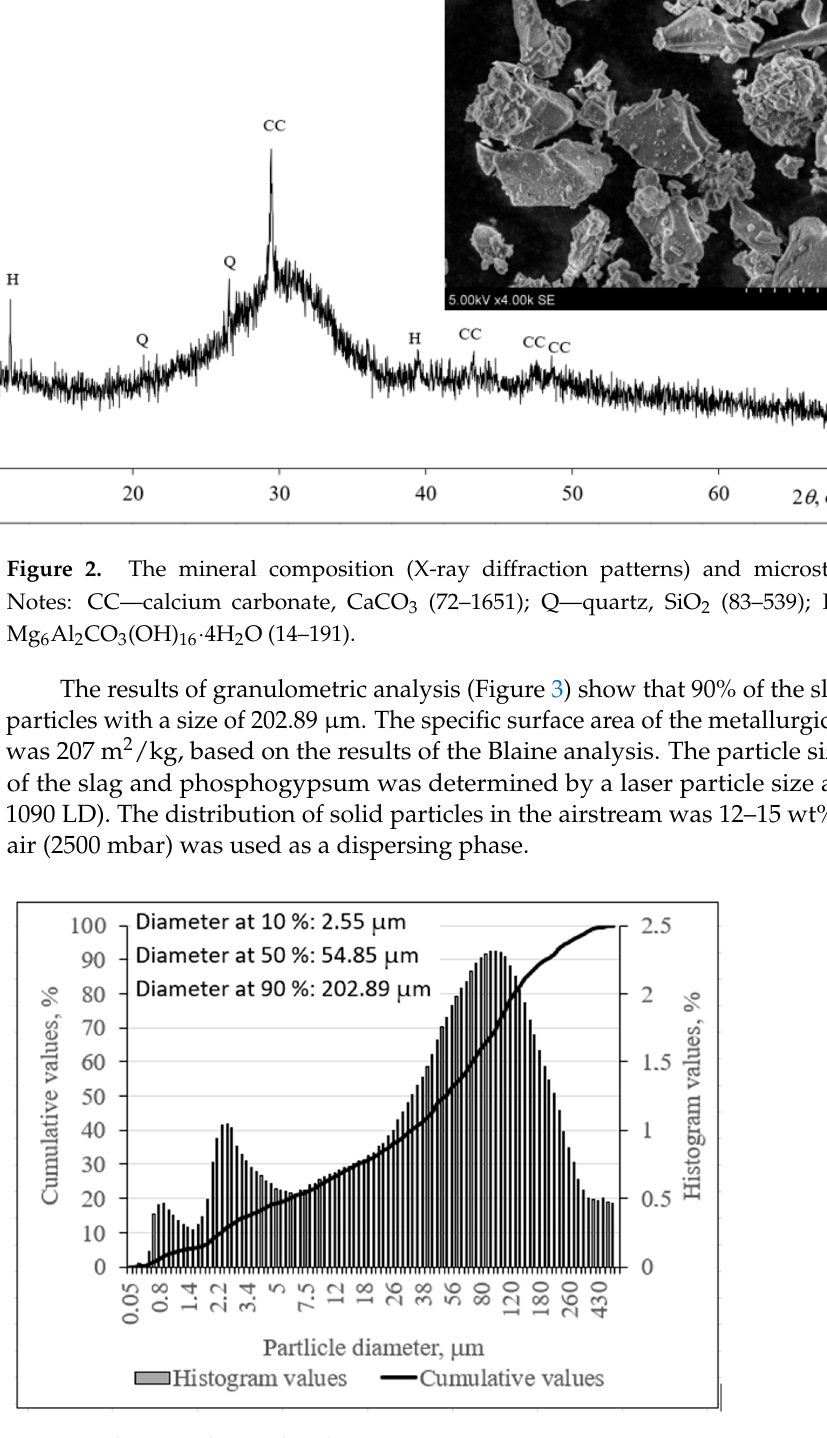
Figure 3. Slag particle size distribution.